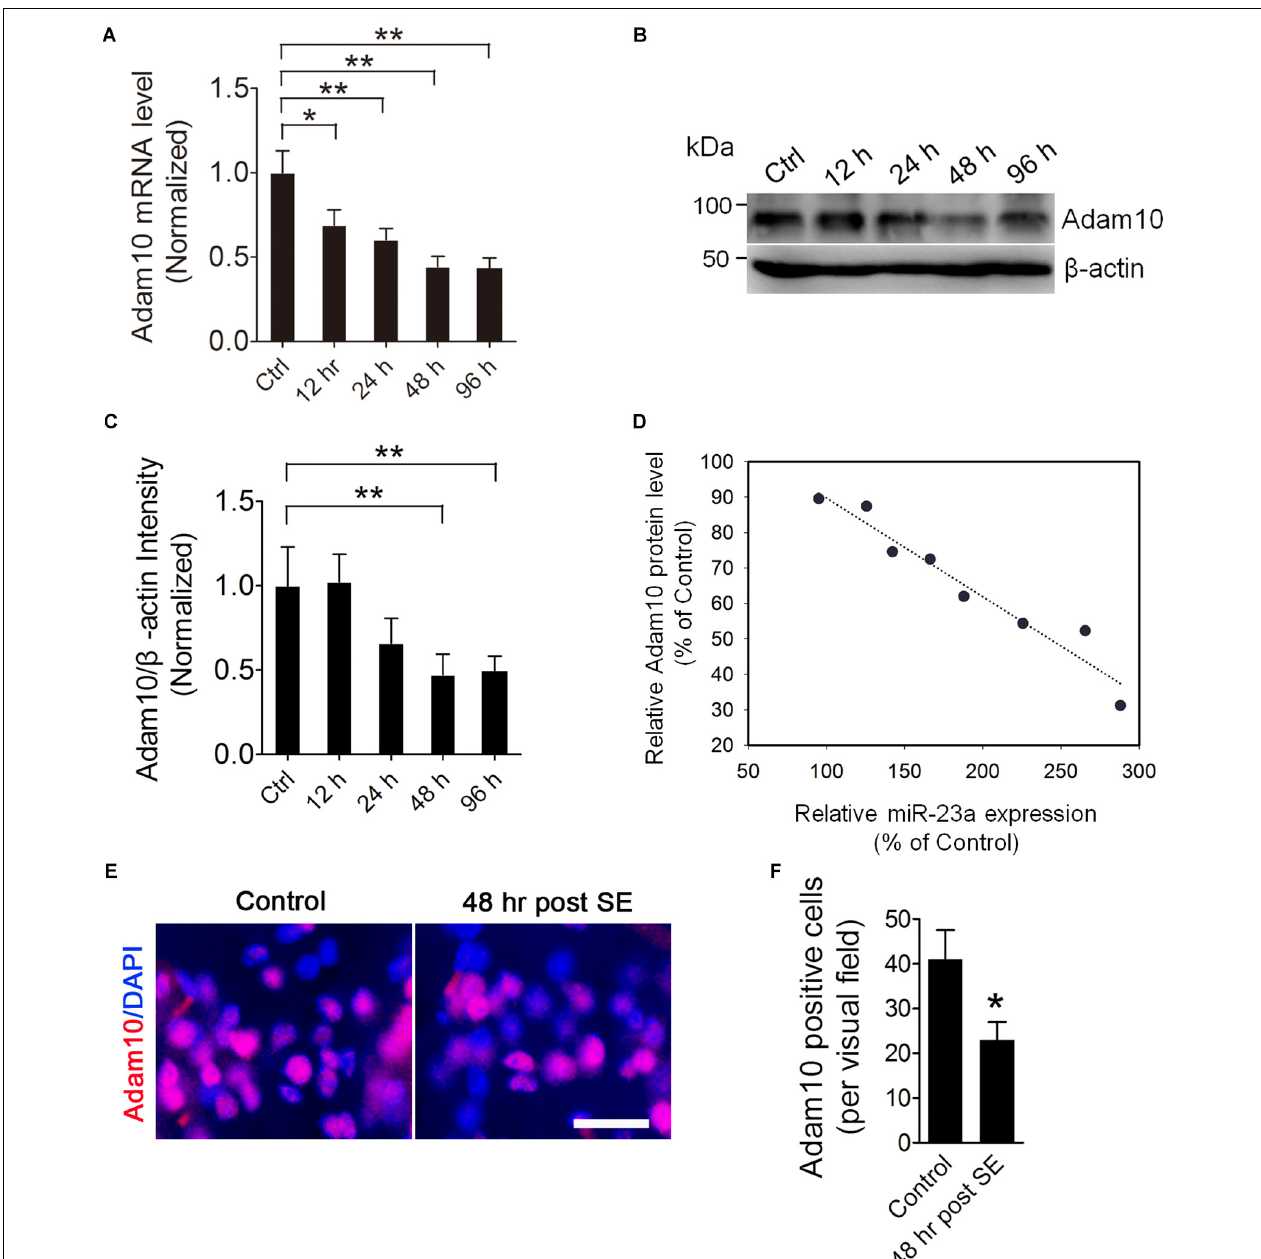
FIGURE 3 | ADAM10 expression is decreased in the hippocampus of TLE mice. (A) qRT-PCR analysis of ADAM10 expression in the hippocampus of ctrl, 12, 24, 48, and 96 h post-SE mice ( F 4 , 20 = 7.19, p = 0.012, 12 h vs. ctrl; p = 0.007, 24 h vs. ctrl; p = 0.002, 48 h vs. ctrl; p = 0.001, 96 h vs. ctrl) ( n = 5). (B,C) Western blotting analysis of ADAM10 protein levels in the hippocampus of ctrl, 12, 24, 48, and 96 h post-SE mice ( F 4 , 20 = 2.88, p = 0.006, 48 h vs. ctrl; p = 0.009, 96 h vs. ctrl) ( n = 5). (D) Pearson correlation analysis of the correlation of relative ADAM10 protein level with miR-23a expression in the hippocampus of TLE mice ( r = –0.97, p < 0.0001). (E) Representative images of ADAM10 immunostaining in the hilus region of hippocampal DG of vehicle ctrl and 48 h post-SE mice. (F) Bar graphs showing the quantification of ADAM10-positive cells in the hippocampus of the vehicle ctrl and 48 h post-SE mice, respectively ( p = 0.035) ( n = 5). Values are mean ± SEM. ∗ p < 0.05, ∗∗ p < 0.01, unpaired two-tailed Student’s t -test and one-way ANOVA. Scale bar = 50 µ